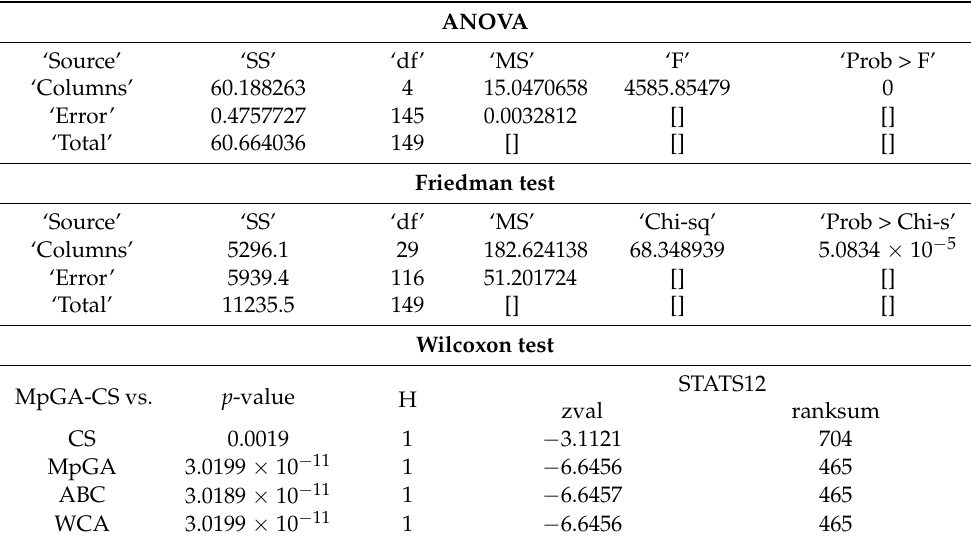
Figure 4. Box plot for the results from parameter identification of E. coli FP model. The performance of the MpGA-CS hybrid is compared with the performance of CS, MpGA, ABC, and WCA based on the three statistical tests—parametric test ANOVA and nonparametric tests Freidman and Wilcoxon. The tests are run in MATLAB using functions ‘ anova1 ’, ‘ ranksum ’, and ‘ friedman ’ on the obtained results of objective function J over 30 runs of each algorithm. The results are presented in the Table 4. Table 4. Parameter identification of E. coli results from statistical